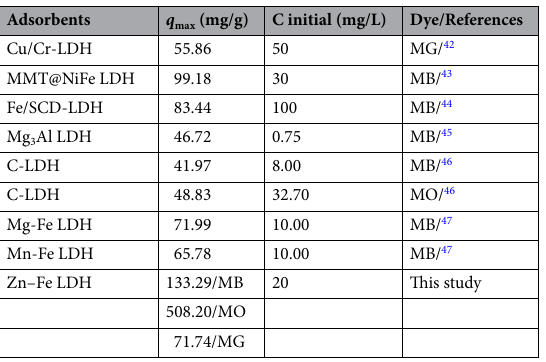
Table 2. Comparison of the maximum adsorption capacities for the removal of MO, MB or MG using different LDHs as adsorbents.